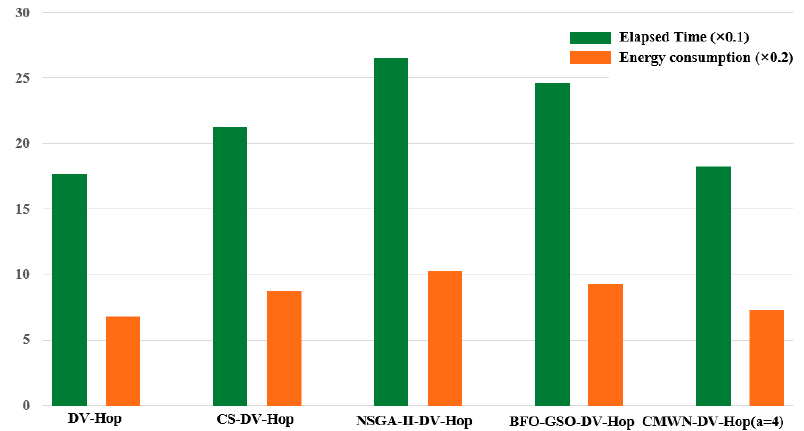
Figure 12. Comparison of elapsed time and energy consumption by each algorithm.